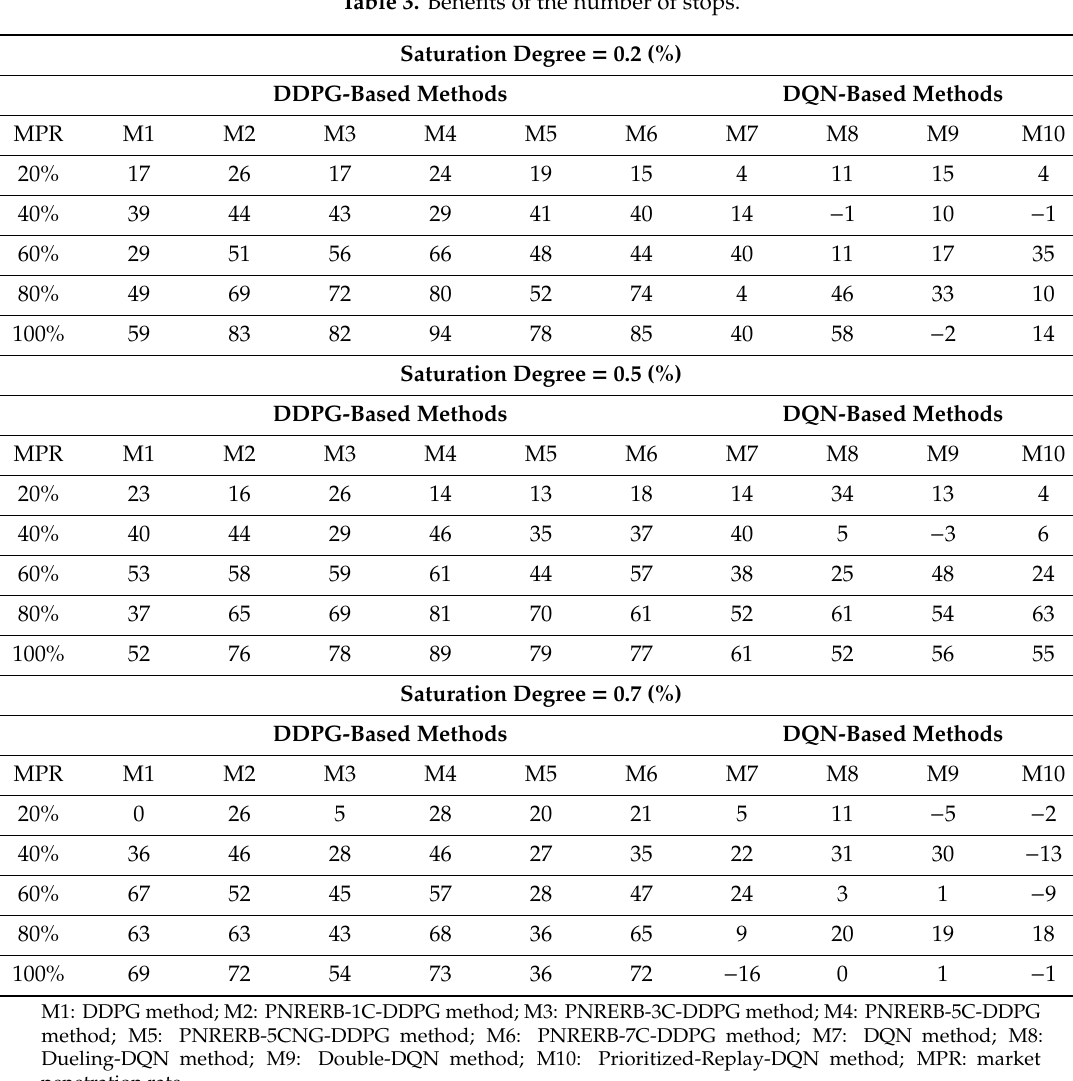
Table 3. Benefits of the number of